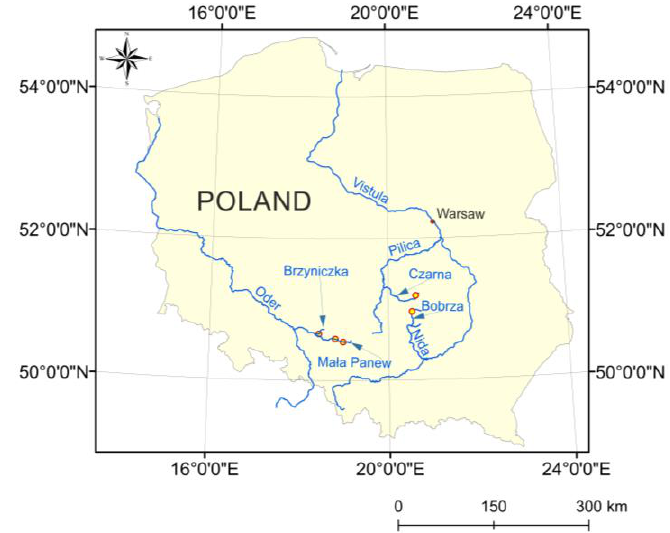
Fig. 1. Location of the research